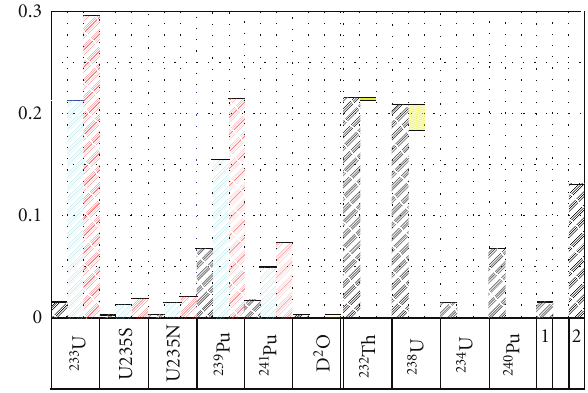
Figure 3: Heavy water-cooled reactor neutron balance in campaign with equilibrium by fuel nuclides regime.